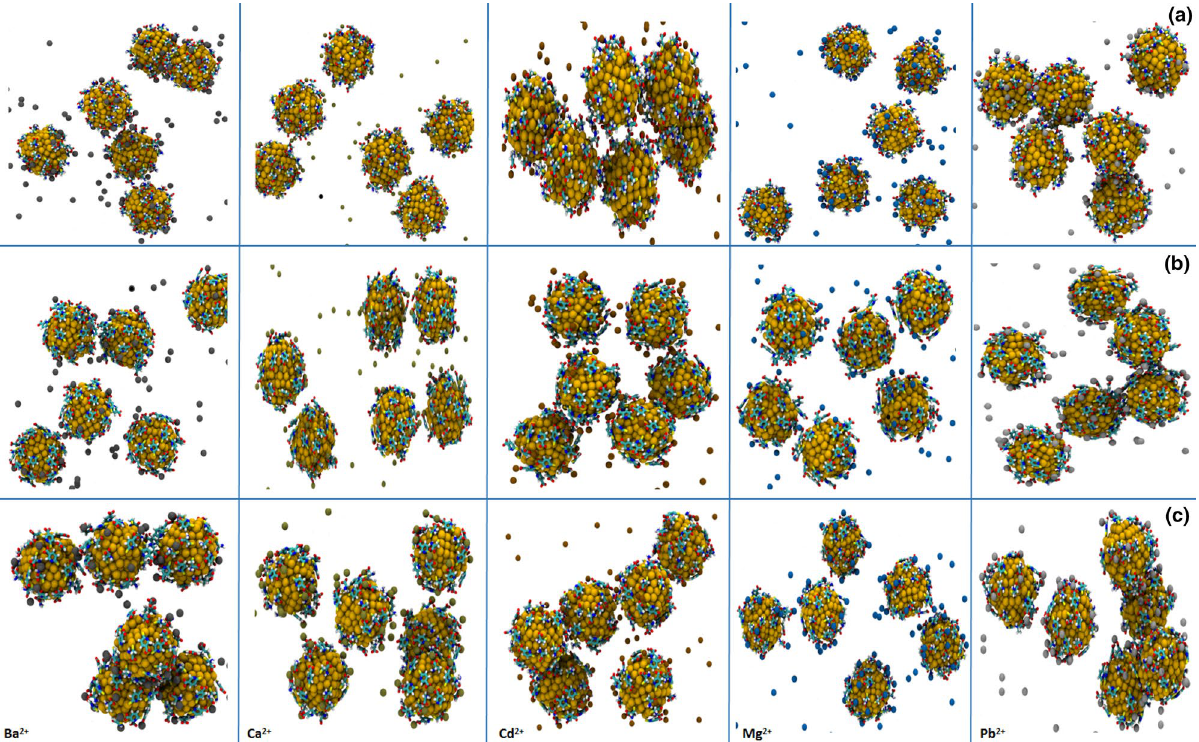
Figure 4. The obtained structures of CYS-AuNPs ( a ), MNA-AuNPs ( b ), and MNA-CYS-AuNPs ( c ) after 50 ns MD simulations in the presence of different metal